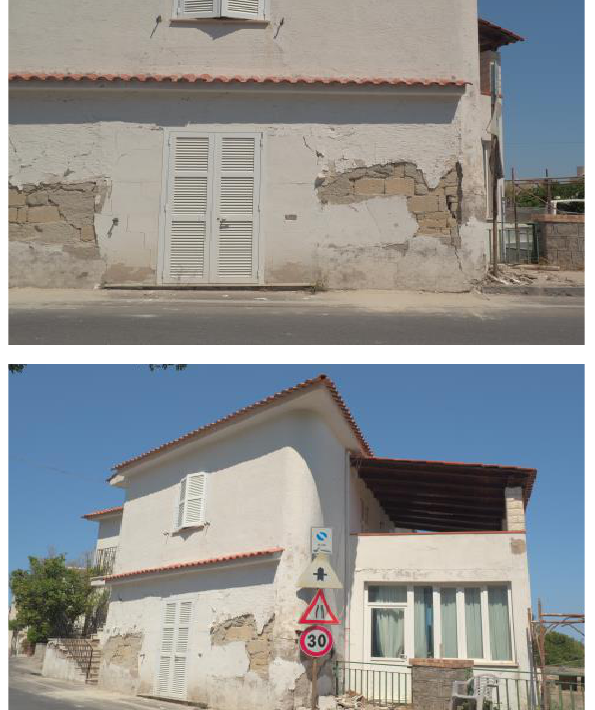
Figure 10. Images of damages by UAV of a building in Lacco Ameno